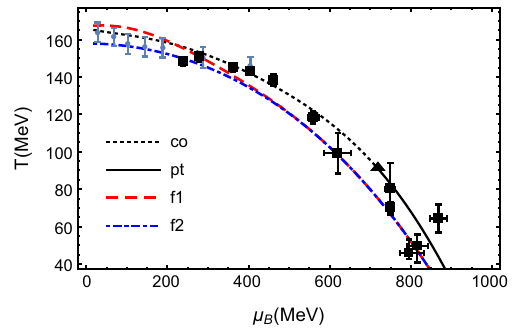
Fig. 9 The chiral phase transition line for the u , d quark in the realis- tic PNJL model and freeze-out lines extracted from experiments. The = 720MeV , T E = CEP is marked by a triangle and located at (μ E B 93MeV ) . The phase transition and crossover are shown by black line and black dotted line, respectively. The freeze-out temperatures and baryon number chemical potentials extracted from BES-I at RHIC [42– 44] are shown in dots, and the freeze-out temperatures and baryon num- ber chemical potentials for lower energy heavy-ion collisions summa- rizedin[47]areshowninsquares,andtwofittedfreeze-outlines f 1 , f 2 are shown by long dashed and dashed-dotted lines, respectively